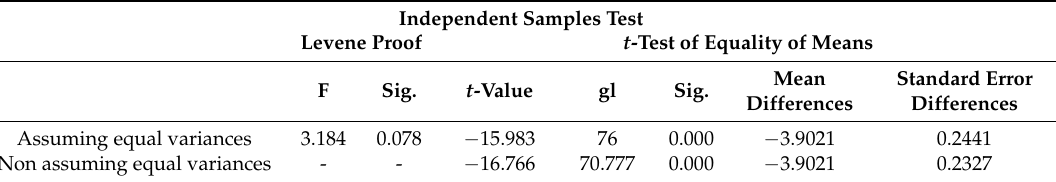
Table 1. Results of the Student’s t -test for the comparison of means in independent